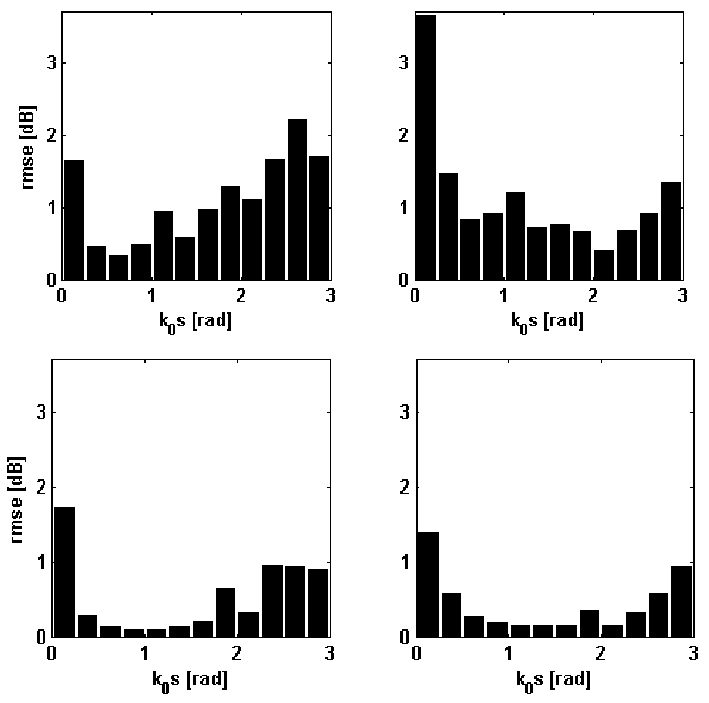
Table 5. Same as Table 4, but for 